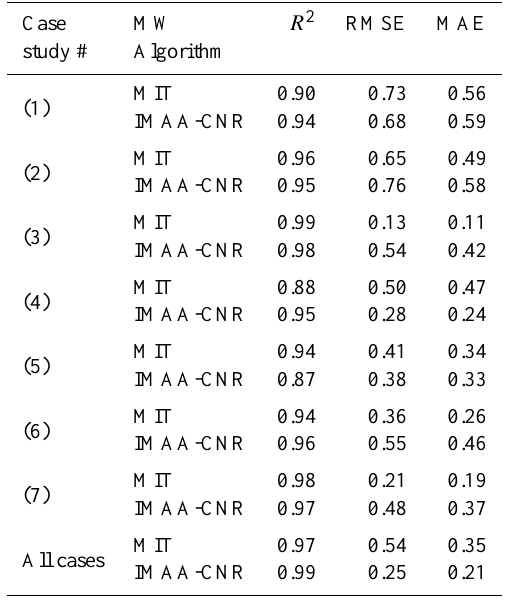
Table 5. Continuous statistics